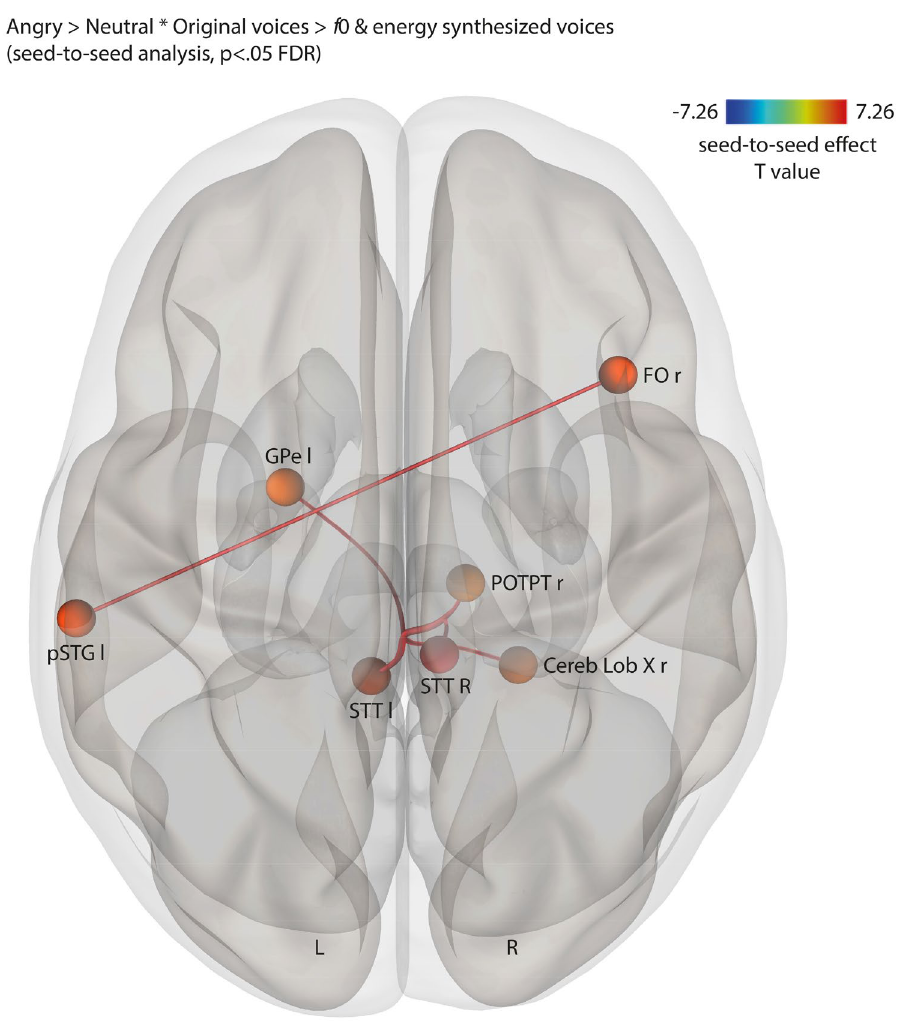
Figure 3. Coupled seed-to-seed, gPPI functional connectivity for the interaction between the Emotion and the Acoustic parameter factors contrasting angry > neutral voices * original > f 0 & energy synthesized voices, corrected for multiple comparisons ( p < .05 FDR). l and L: left; r and R: right; FO: frontal operculum; GPe: external globus pallidus; pSTG: posterior superior temporal gyrus; STT: spinothalamic tract of the brainstem; POTPT: parieto-occipito-temporo-pontine tract of the brainstem; Cereb Lob: cerebellum